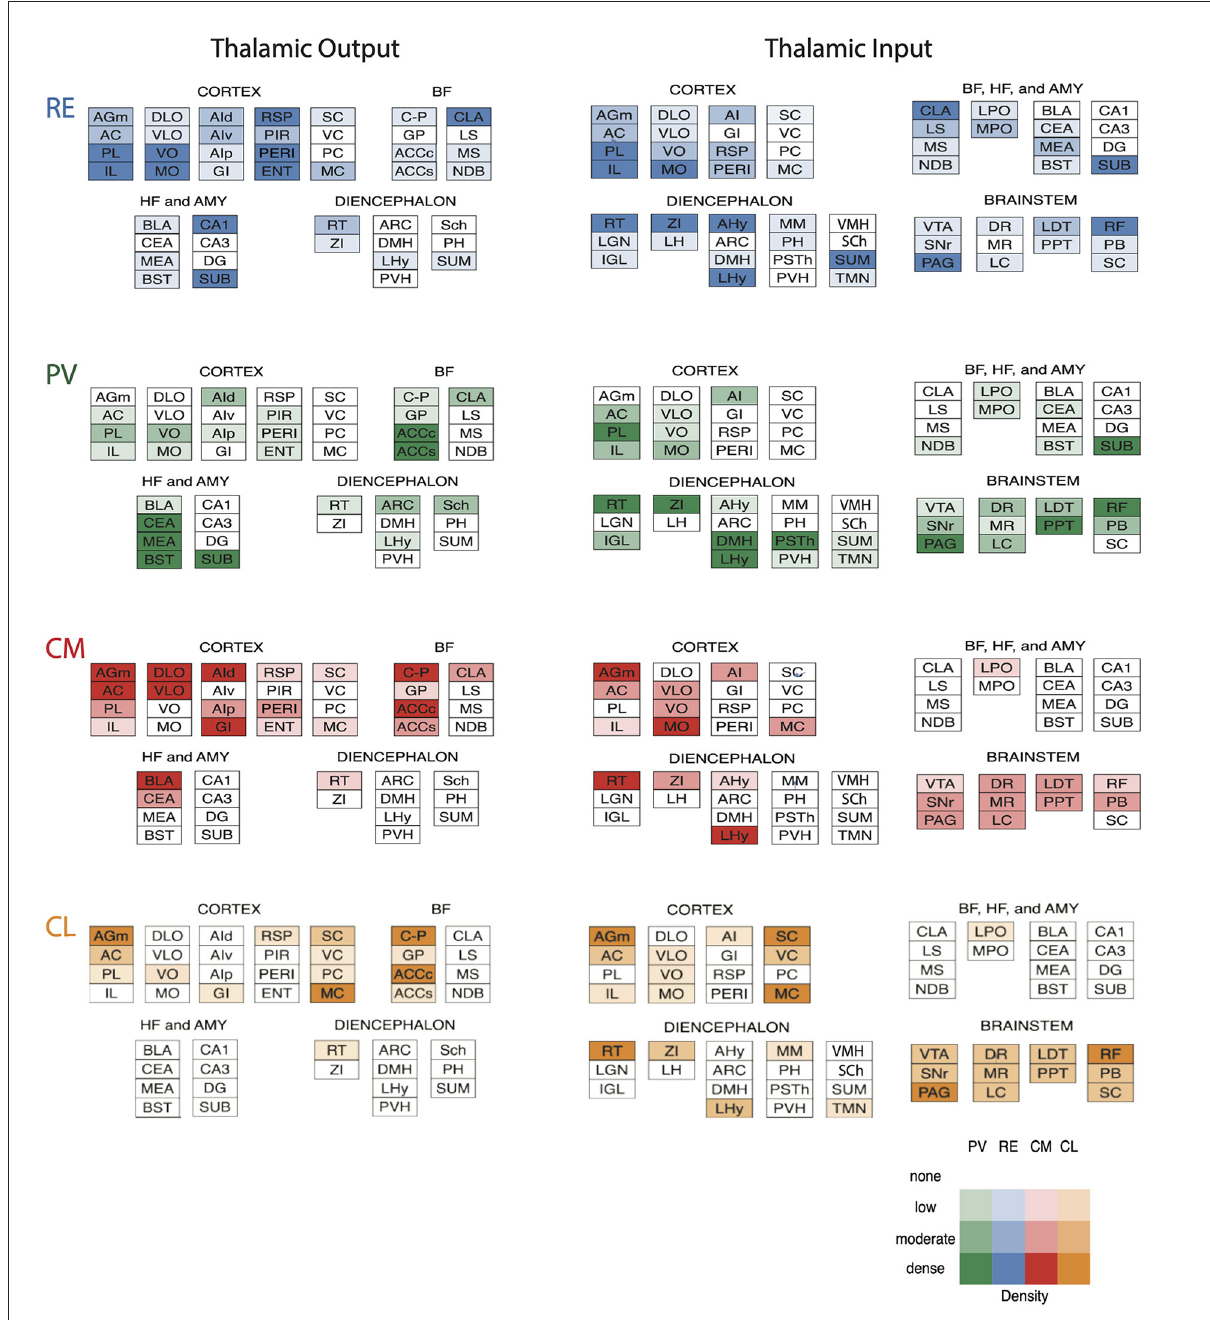
FIGURE9 Schematic representation of the patterns and density of outputs (left) and inputs (right) of nucleus reuniens (RE) (blue) and the paraventricular (PV) nucleus (green) of the midline thalamus and the central medial (CM) (red) and central lateral (CL) (orange) nuclei of the rostral intralaminar thalamus. Note, while there are substantial differences in inputs/outputs from the cortex, striatum, and amygdala to the midline and rostral intralaminar nuclei, all nuclei receive strong (and overlapping) projections from brainstem “arousal-related” cell groups. Color coded density chart for input and outputs to each site at the bottom right. AC, anterior cingulate cortex; ACCc, nucleus accumbens core division; ACCs, nucleus accumbens shell division; AGm, medial agranular cortex; AHy, anterior hypothalamus; AI, agranular insular cortex; AId, dorsal insular cortex; AIp, posterior insular cortex; AIv, ventral insular cortex; AMY, amygdala; ARC, arcuate nucleus of hypothalamus; BF, basal forebrain; BLA, basolateral amygdala; BST, bed nucleus of the stria terminalis; CA, cornu ammonis; CEA, central nucleus of amygdala; CLA, claustrum; C-P, dorsal striatum; DG, dentate gyrus; DLO, dorsolateral orbital cortex; DMH, dorsomedial hypothalamus; DR, dorsal raphe nucleus; ENT, entorhinal cortex; GI, granular insular cortex; GP, globus pallidus; HF, hippocampus; IL, infralimbic cortex; IGL, intergeniculate leaflet of thalamus; LC, locus coeruleus; LDT, laterodorsal tegmental nucleus; LGN, lateral geniculate nucleus of thalamus; LH, lateral habenula; LHy,